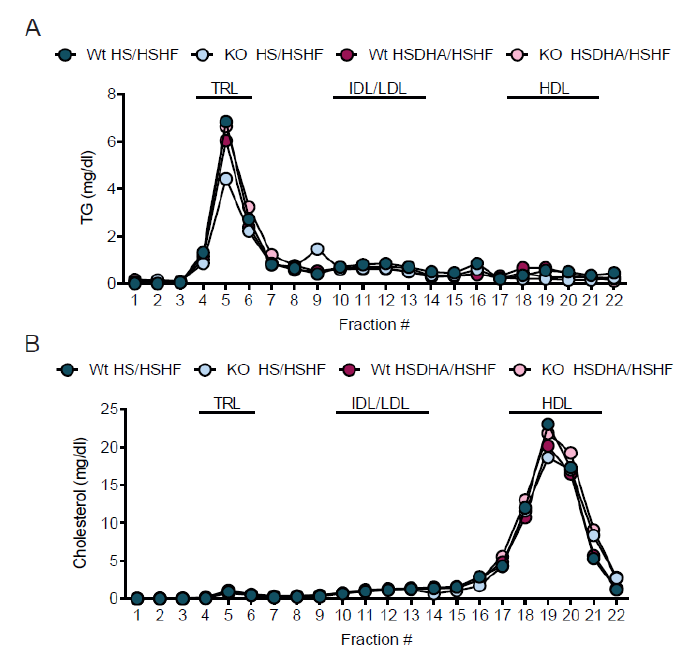
Figure 8. Triglyceride lipoprotein profile in Elovl2 - / - mice is reversed to wild-type levels after high-sucrose DHA-enriched (HSDHA) treatment. Serum lipoprotein triglyceride ( A ) and cholesterol ( B ) profiles were determined on pooled serum from four to five mice per group of wild-type and Elovl2 - / - mice fed high-sucrose (HS) or high-sucrose DHA-enriched diet (HSDHA) followed by high-sucrose, high-fat (HSHF) diet. Fractions 4–6 represent TG-rich lipoproteins (TRL), fractions 10–15 low density lipoprotein and mainly remnant particles (LDL), and fractions 16–23 represent high density lipoproteins